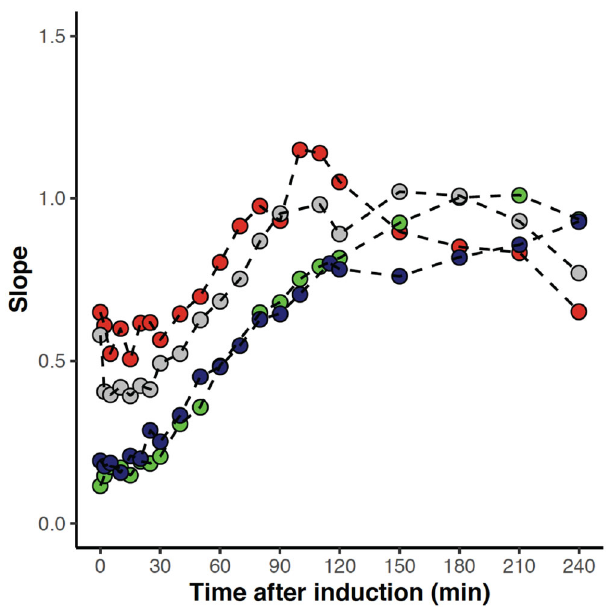
Fig. 7 Slope of fl uorescent population over time. For each time point, the slope of log-transformed red fl uorescence vs log-transformed green fl uorescence is calculated for L57G (dark blue) M40A (green), Q33Y (red) and wt (grey). One of three replicates are shown for each